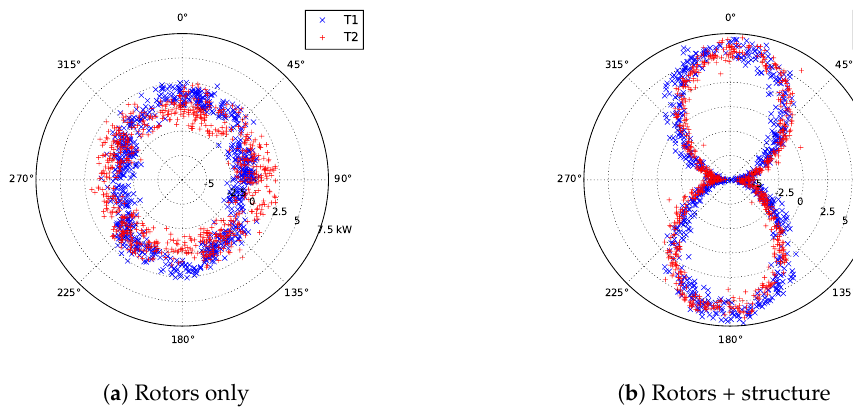
Figure 18. Rotor-averaged FFT plots of the power time-series, for ( a ) rotors only and ( b ) rotors + structure. There is a pronounced spike at 0.4 Hz for the simulation that includes the support structure.